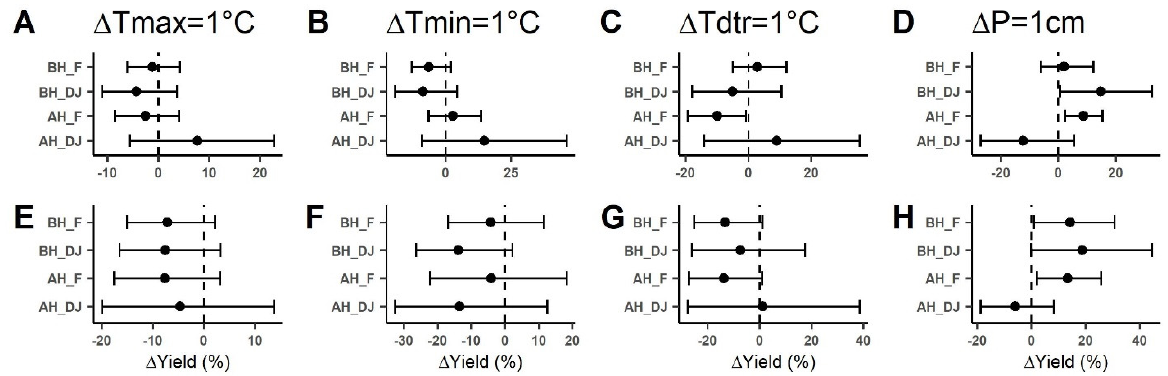
Figure 4. Percentage changes of yields of ‘Otal’ ( A – D ) and ‘Thual’ ( E – H ) with 1 ◦ C temperature increase (Tmax, Tmin, and Tdtr) and 1 cm precipitation increase at the periods of 10 days BH and AH in Fairbanks and Delta Junction. BH_F and AH_F represent the periods of 10 days BH and AH in Fairbanks, respectively; BH_DJ and AH_DJ represent the periods of 10 days BH and AH in Delta Junction.